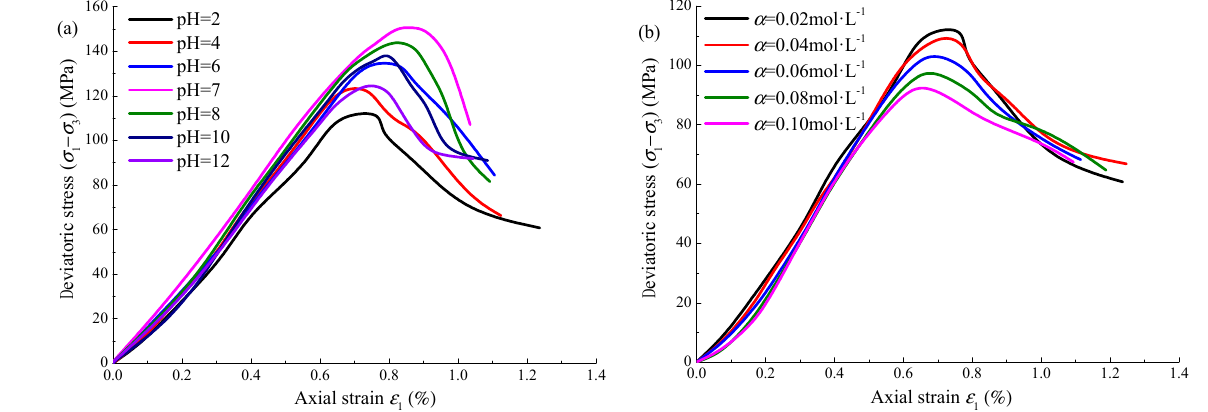
Figure 3. Axial stress–strain curve of Na 2 SO 4 corroded sandstone: ( a ) α = 0.02 mol · L − 1 ; ( b ) pH = 2. Table 2. Mechanical parameters of Na 2 SO 4 corroded sandstone ( σ 3 = 10 MPa).